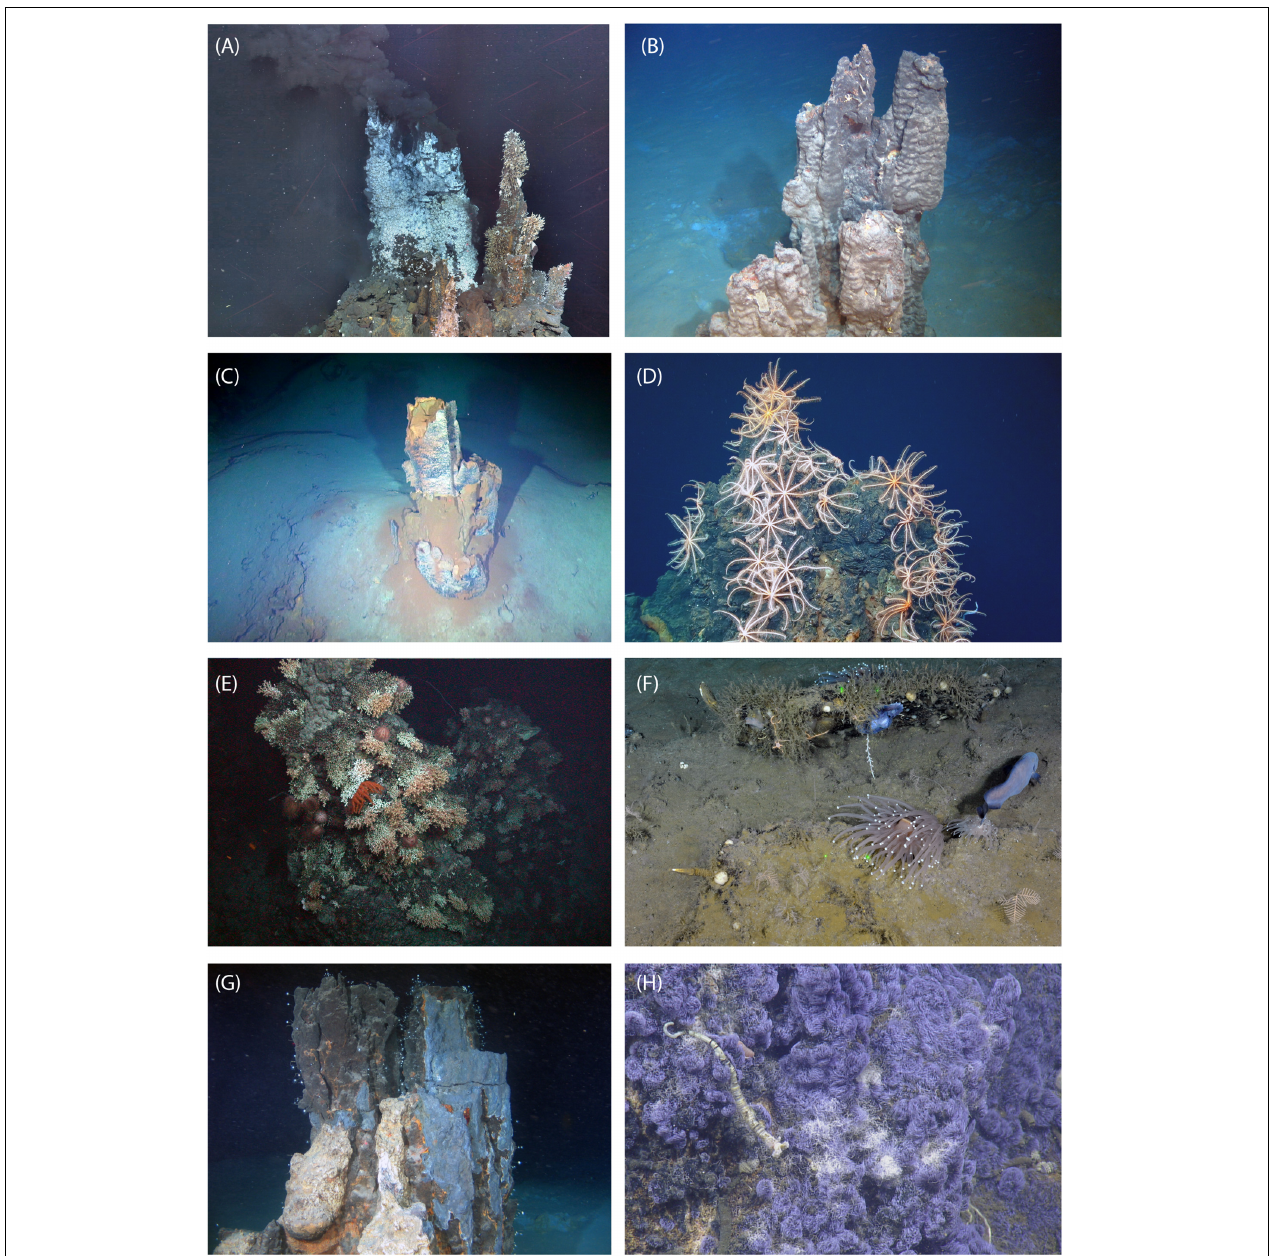
FIGURE 1 | Inactive sulfide ecosystems: examples providing a glimpse of the variety of megafaunal invertebrate characteristics to be found on sulfides, including absence of fauna, abundant suspension-feeding brisingid seastars, coral gardens with diverse feeding guilds, and dense carpets of folliculinid ciliates. (A) E9 mosaic (East Scotia Ridge; Marsh et al., 2012): an active (left)-inactive (right) “sulfide complex”; active chimney dominated by the yeti crab ( Kiwa tyleri ) with limpets ( Lepetodrilus n. sp.) on their backs, inactive chimney Vulcanolepas scotiaensis (plus a few actinostolid anemones and the occasional K. tyleri ); mosaic by L. Marsh, courtesy Jon Copley, National Oceanography Centre and the University of Southampton. (B) Manus Basin (SE Pacific; Erickson et al., 2009): inactive sulfide chimney on sediment, with barnacles, shrimp, courtesy Nautilus Minerals Niuguini Ltd. (C) “New Mound,” TAG Hydrothermal Field (Mid-Atlantic Ridge; modified from Petersen et al., 2018), courtesy Bram Murton, National Oceanography Centre and Natural Environment Research Council. (D) Pito Seamount (SE Pacific) inactive chimney with brisingid seastars, courtesy Mike Cheadle, Barbara John, University of Wyoming. (E) Kermadec Arc (modified from Boschen et al., 2016): inactive sulfide with a coral- and urchin-dominated assemblage, courtesy of Rachel Boschen-Rose (Seascape Consultants), Malcolm Clark (NIWA), Ashley Rowden, (NIWA) and Neptune Minerals Inc. (F) Middle Valley (Juan de Fuca Ridge): inactive sulfide chimney fragment and sediment-dusted sulfide, with a diverse invertebrate assemblage including stalked barnacles, brooding octopods, corals, anemones, sponges, tunicates, hydroids, fish, courtesy Verena Tunnicliffe, University of Victoria. (G) Manus Basin (SE Pacific; Collins et al., 2012) inactive sulfide chimney with “lollipop sponges” (carnivorous sponges in the family Cladorhizidae), courtesy Nautilus Minerals Niuguini Ltd. (H) Northern Guaymas Basin: inactive sulfide with folliculinid ciliates in blue tubes; a siboglinid worm in the image suggests the sulfide was recently hydrothermally active or perhaps even continues to flow very weakly; with permission (modified from Soule et al., 2018).